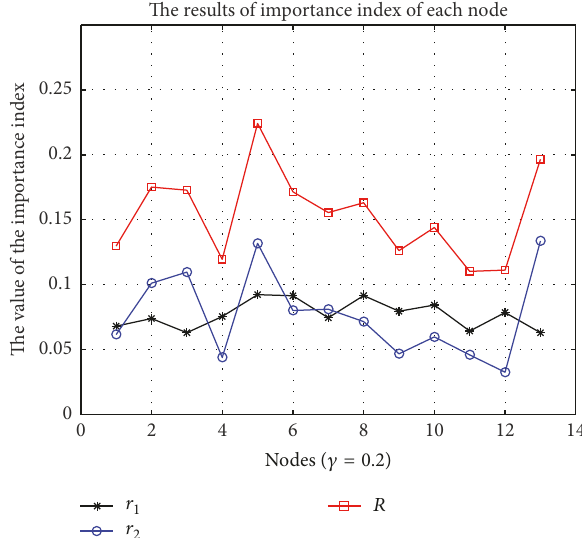
Figure2:Thevaluesoftheimportanceindexofnodeswhen 𝛾 = 0.2 .